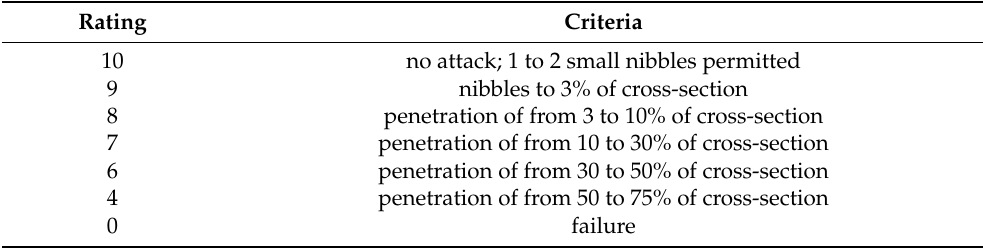
Table 1. Rating system of protection level against termite attack.